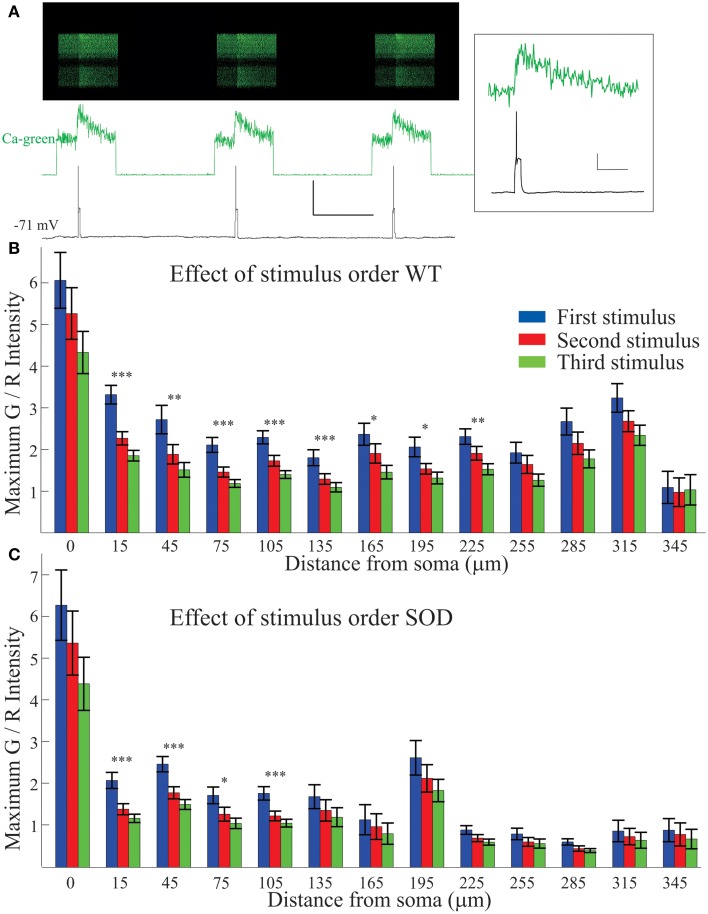
Decrease in Ca2+ signal with repeated stimuli. Each stimulus protocol (50, 10, and 200 ms depolarizing pulses) included three pulses of identical duration which were normally averaged together. The first stimulus pulse elicited the largest Ca2+ signal, as shown in a typical motoneuron in (A), with 50 ms pulses. The Ca2+ green-1 fluorescent intensity (top two traces) shows a decreased Ca2+ signal in successive events though it returns to baseline after each event. The action potential (bottom trace) remains unchanged. Scale bar = 50 mV vertical, 1 s horizontal. Inset: High resolution zoom of the first stimulus. Scale bars = 20 mV vertical, 200 ms horizontal. (B,C) Each stimulus (first in blue, second in red and third in green) is averaged separately for WT (B) and SOD1 (C). Over all the neurons recorded, significantly smaller Ca2+ transients were evoked with second and third events. Error bars = ±SEM, significance determined at each location with One Way ANOVA *p < 0.05; **p < 0.01; ***p < 0.001.